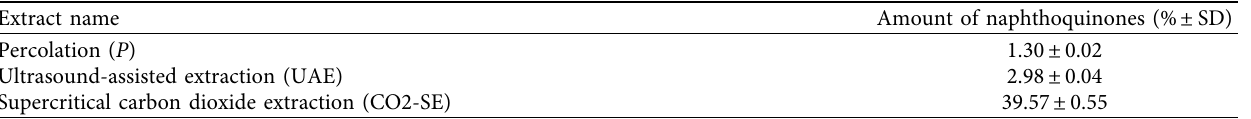
Figure 2: Thin-layer chromatogram of different extracts from the roots of O. gmelinii . (1) chromatogram without treatment; (2) chro- matogram after treatment with ammonia vapour; (3) chromatogram scheme; CO2-SE: supercritical carbon dioxide extraction; UAE: ultrasound-assisted extraction; P: percolation extraction. Table 2: Content of the sum of naphthoquinones in extracts from O. gmelinii